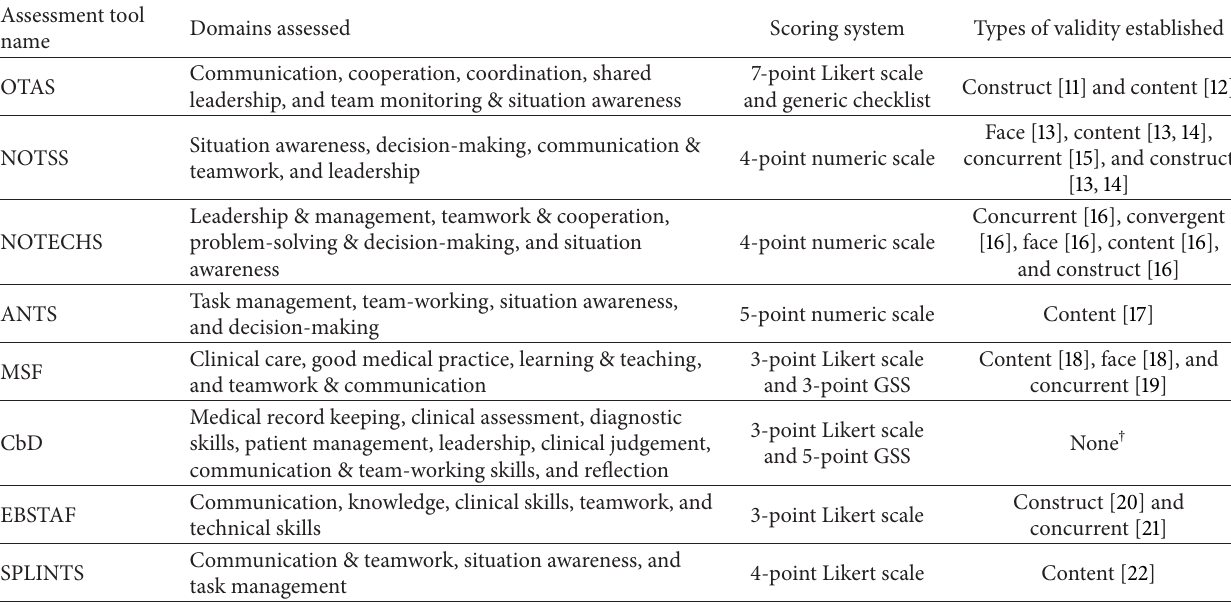
Table 1: Teamwork assessment tools and the types of validity established in the surgical environment. Assessment tool